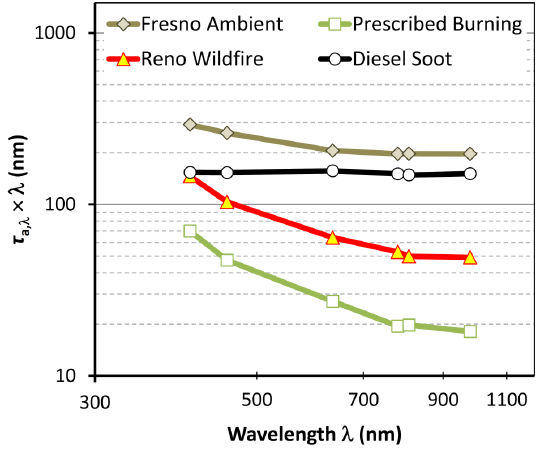
Figure 6. Product of absorption optical depth ( τ a ,λ ) and wavelength ( λ) as a function of λ by sample type. τ a ,λ shown represents aver- ages over each of the sample